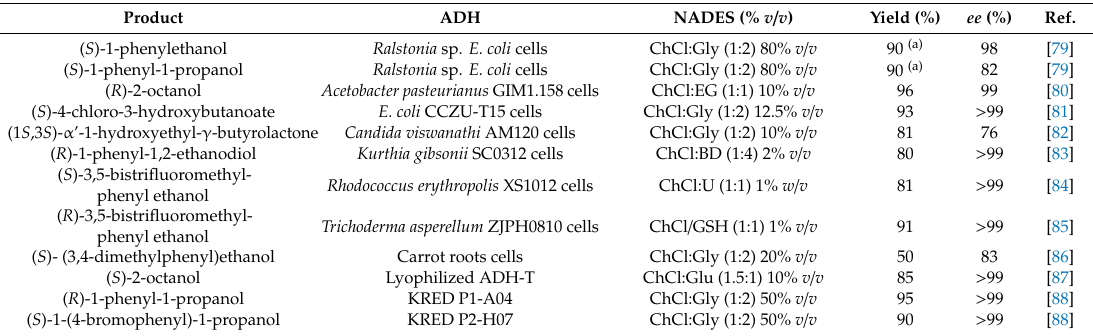
Table 3. Examples of optically active aliphatic and aromatic alcohols that can be obtained employing ADHs in presence of NADES as